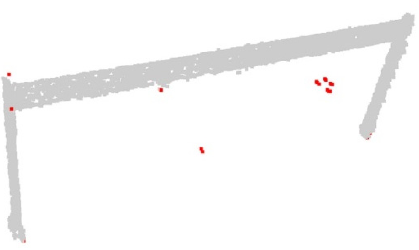
Figure 6. An example of noise filtering for a gate, where the red points are noise and the gray points are the object.